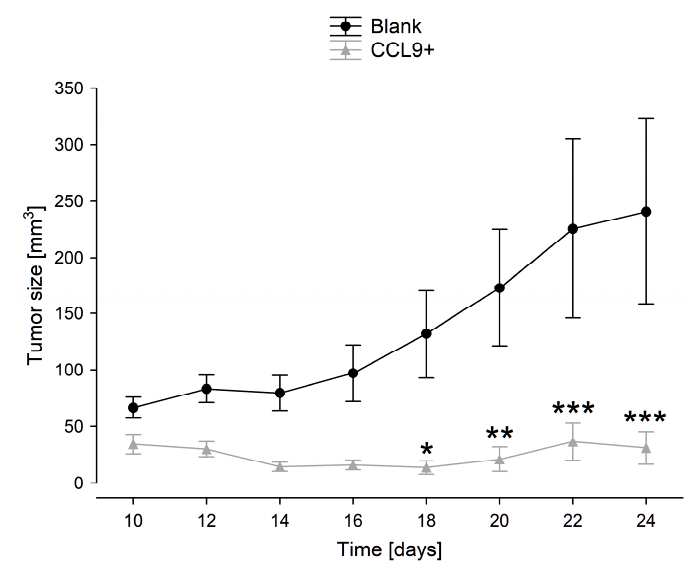
Figure 6. Tumor growth in BALB/c mice injected sc. with blank control CT26 cells or CCL9-overexpressing CT26 cells. One, two, or three asterisk symbols indicate significant results at p < 0.05, p < 0.01, or p < 0.001,